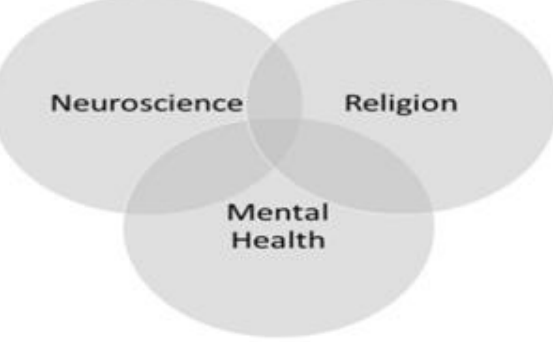
Figure 1. A triune worldview. Interrelationships among neuroscience, religion, and mental health. Together, they can be the basis for a life of fulfillment and joy. From (Klemm 2019).